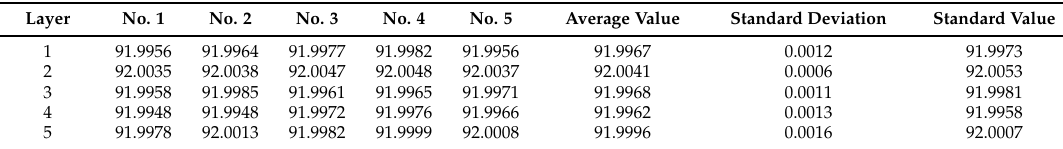
Table 4. Measuring data of Engine Block 3#